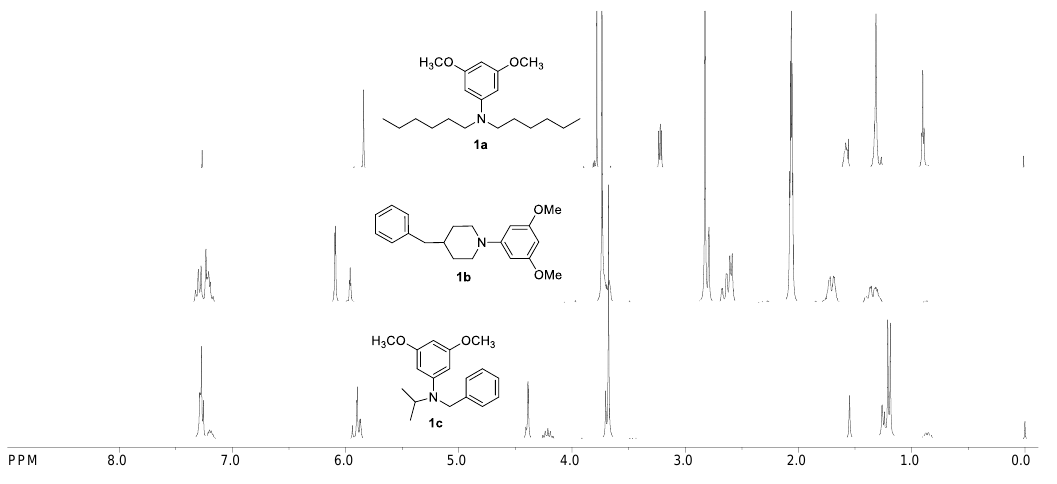
Figure 6. 1 H NMR spectra (CDCl 3 ) of compounds 1a – 1c .